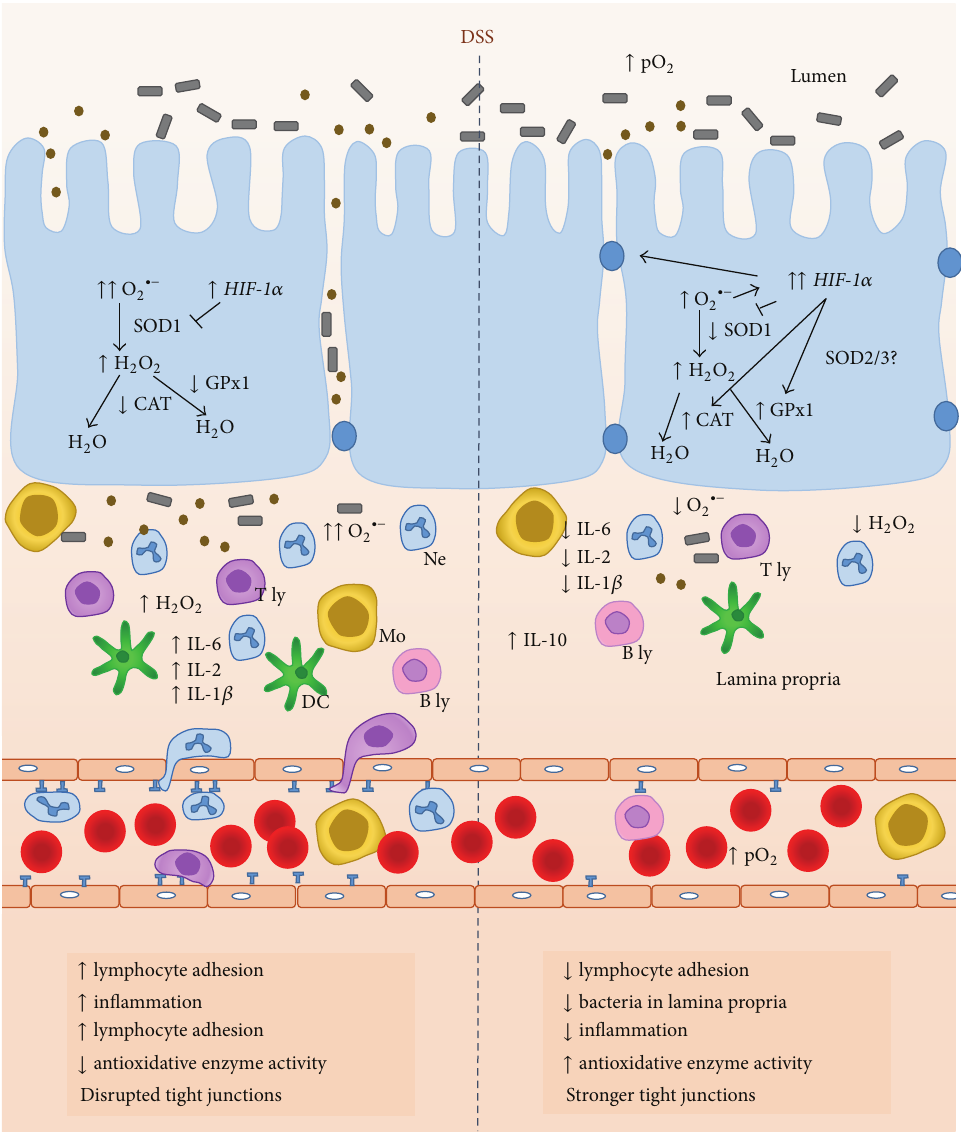
Figure 7: Proposed mechanisms mediating effects of HBO 2 on the inflammation during DSS-induced colitis. Compared to untreated DSS- induced colitis (left of the vertical dotted line), high partial pressure of oxygen during HBO 2 (right) activates HIF-1 𝛼 signaling which leads to higher CAT and GPx1 mRNA expression resulting in reduced oxidative stress in the inflamed colonic mucosa. HIF-1 𝛼 mediated (negative) transcriptional regulation of proinflammatory cytokine IL-6 and reduced oxidative tissue injury leads to decreased neutrophil, monocyte, and lymphocyte adhesion and infiltration to the gut mucosa. In addition, HBO 2 activates genes encoding for barrier-protection and genes responsible for improving tight junction integrity, all together resulting in reduced number of bacteria entering the lamina propria of gut mucosa. T ly, T lymphocyte; B ly, B lymphocyte; DC, dendritic cell; Ne, neutrophil; Mo, monocyte/macrophage; HIF-1 𝛼 , hypoxia inducible factor1alpha;CAT,catalase;GPx1,glutathioneperoxidase1;SOD1,superoxidedismutase1;pO 2 ,partialO 2 pressure; ↑ ,increased; ↓